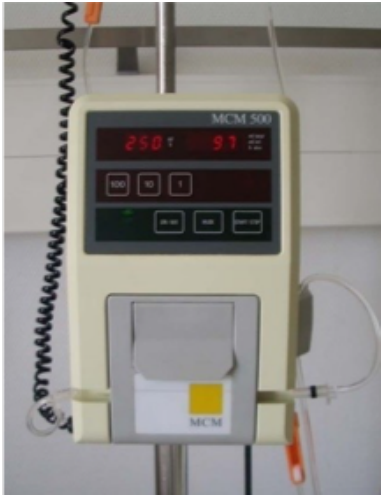
Figure 4. Example vulnerable drug